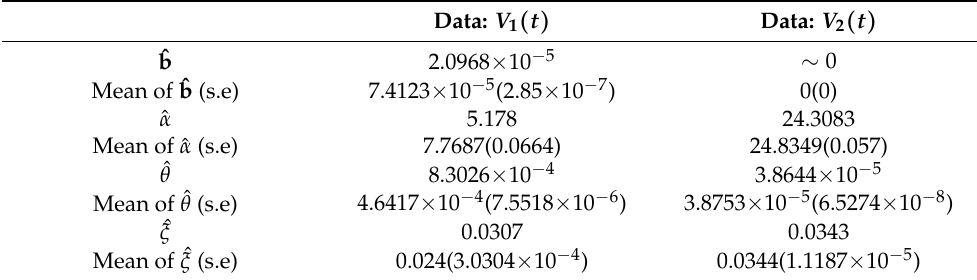
Table 4. Estimated volatility group parameters with empirical data (SLV and GLD).